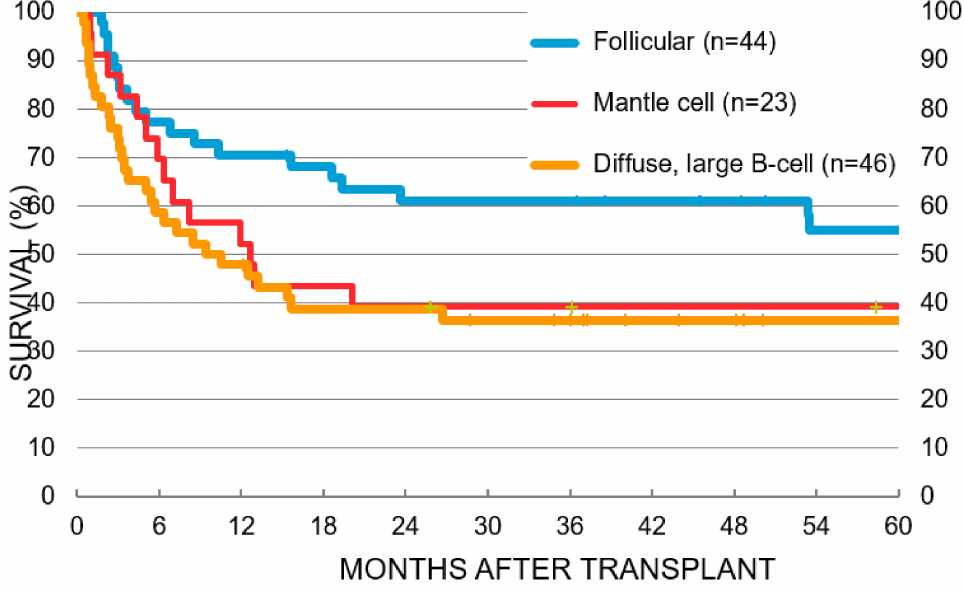
Figure 2. Data from the Center for International Blood and Marrow Transplant Research (CIBMTR) showing survival after first allo-HCT in FL, MCL and DLBCL patients. Reproduced with permission from the National Marrow Donor Program